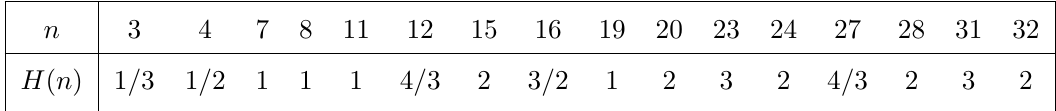
Table 1 . The Hurwitz-Kronecker numbers for the (cid:12)rst few values of n .